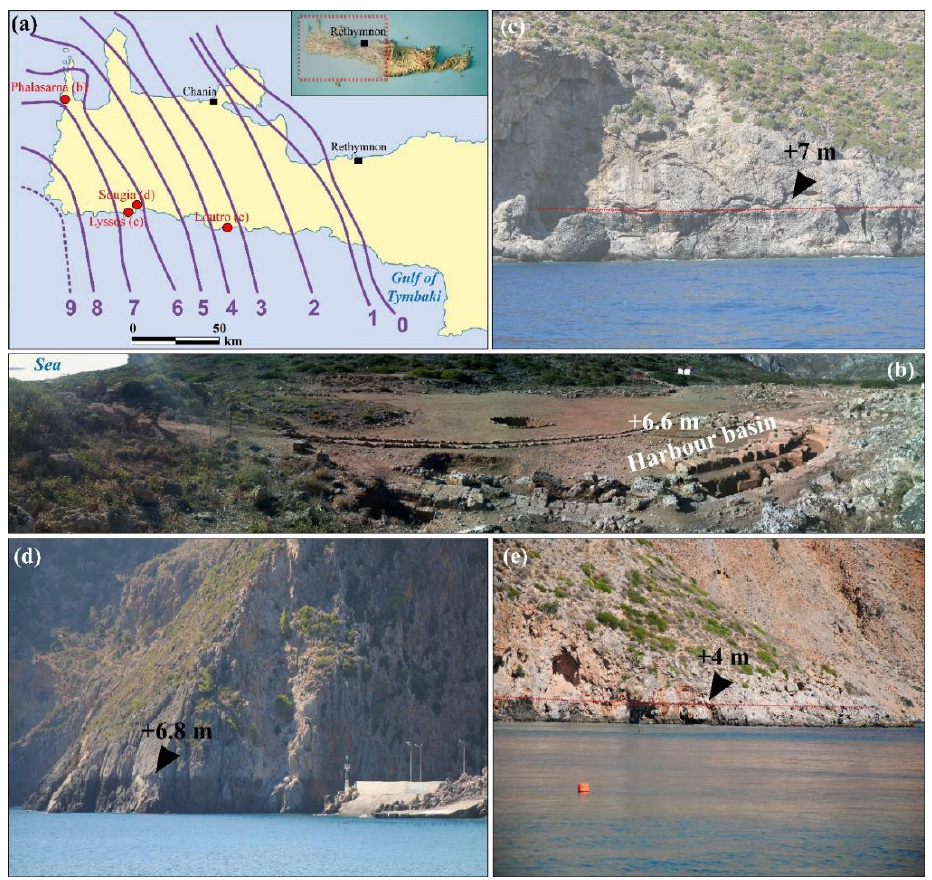
Figure 1. Different views of the 365 CE coseismic bioerosional notch. This notch is related to a regional uplift of the westernmost part of Crete and can be observed at different elevations above present-day sea level ( a ). Purple lines in ( a ) are isobases marking the uplift. Archaeological implications are important since various sites (mostly harbour basins) were landlocked: at Phalarsana ( b ), Lyssos ( c ), Sougia ( d ) and Loutro ( e ).